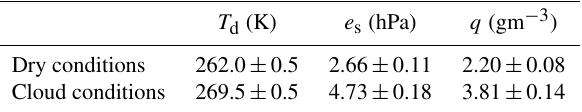
Table 2. Dew point temperature and deduced humidity measures for liquid water content measurements. The increase in dew point temperature was caused by the evaporation of droplets on their way from the ICC to the dew point hygrometer. e s was calculated from the Magnus approximation to the Clausius–Clapeyron equation, q from Eq.